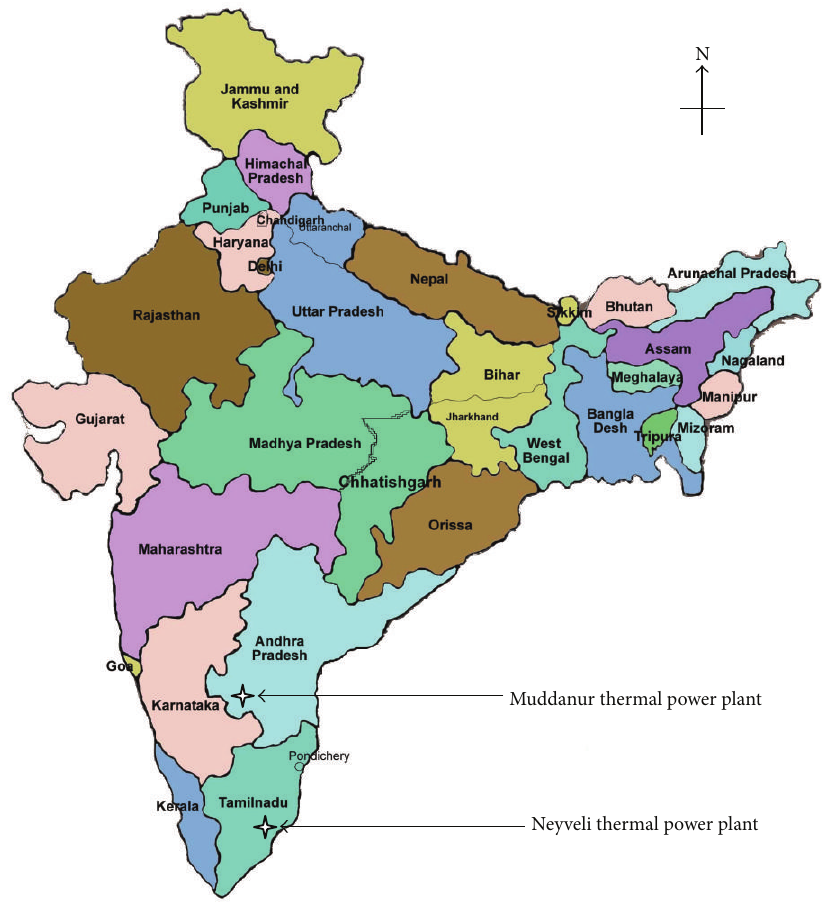
Figure 1: Location map of the thermal power plants (map not to scale).